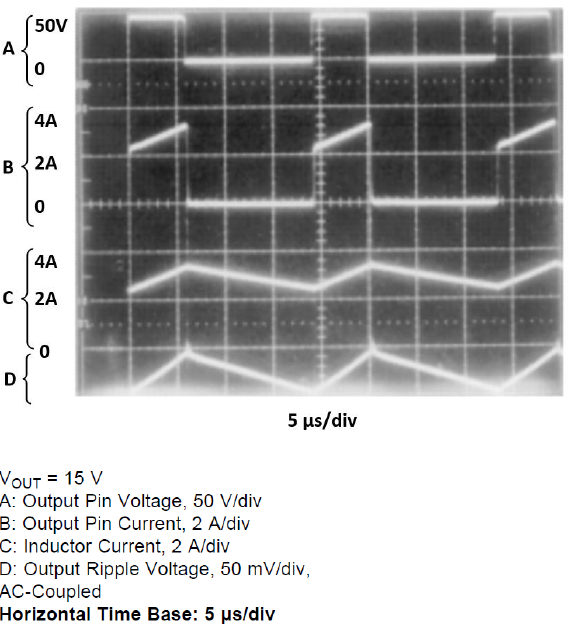
Figure 6. Measured main values of the converter obtained from the LM2576 datasheet.